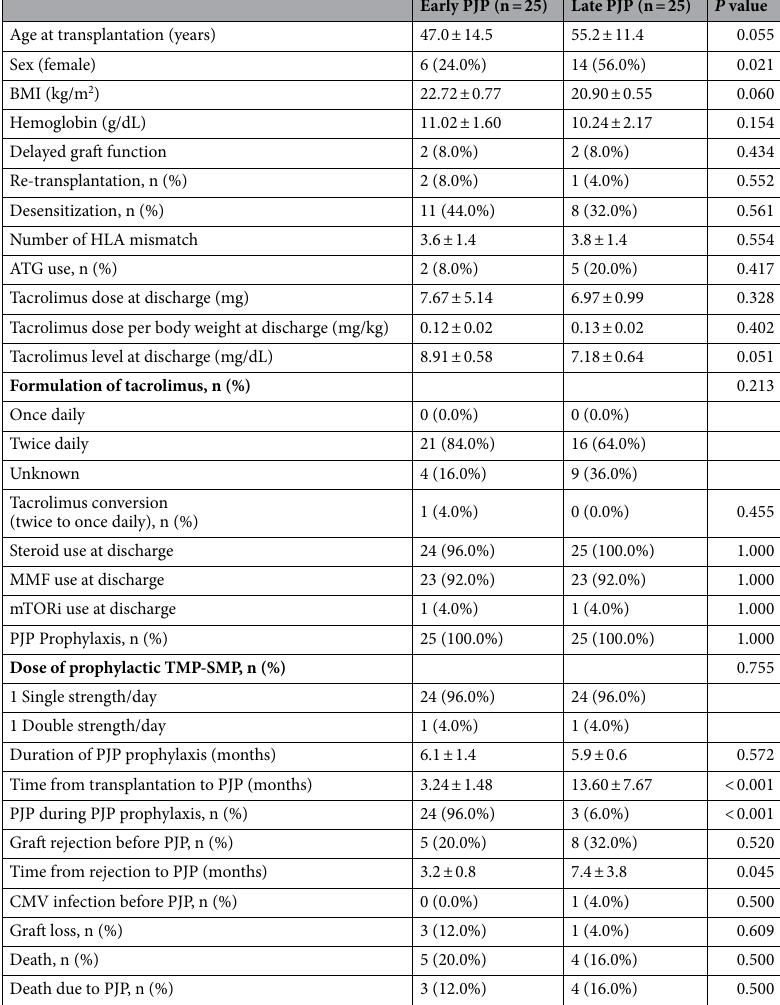
Table 4. Comparison of Pneumocystis jirovecii pneumonia according to occurrence time. Data are presented as mean (standard deviation), or n (%). Abbeviations : ATG, anti-thymocyts globulin; BMI, body mass index; CMV, cytomegalovirus; mTORi, mammalian target of rapamycin inhibitor; PJP, pneumocystis jirovecii pneumonia; TMP-SMX,